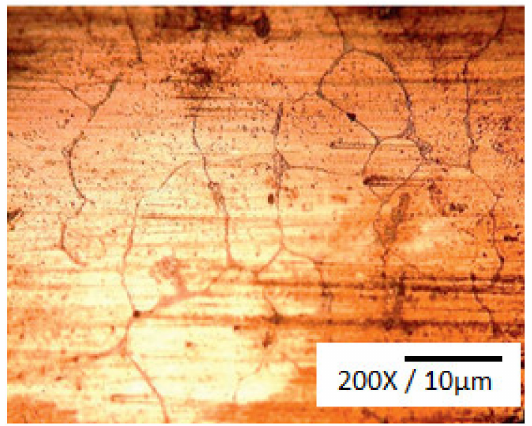
Figure 3. Microstructure of homogenized Cu-10Sn alloy [5].